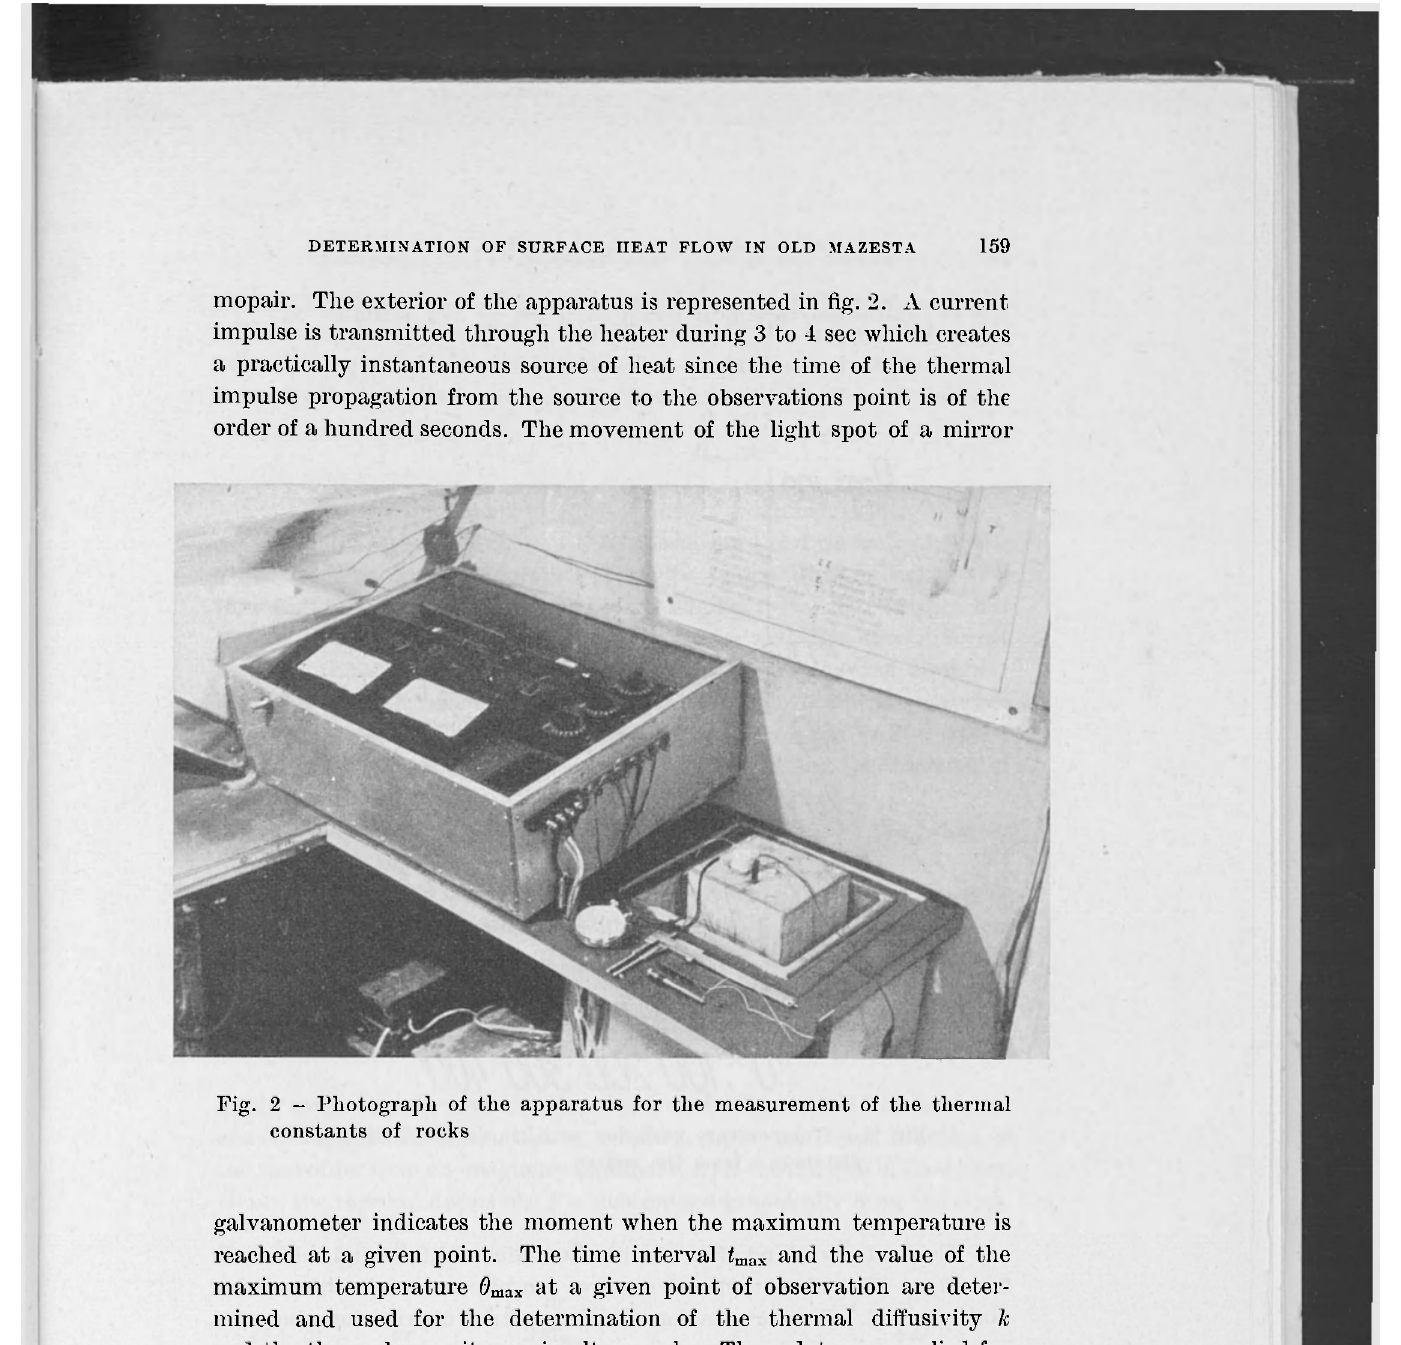
Fig. 2 - Photograph of the apparatus for the measurement of the thermal constants of